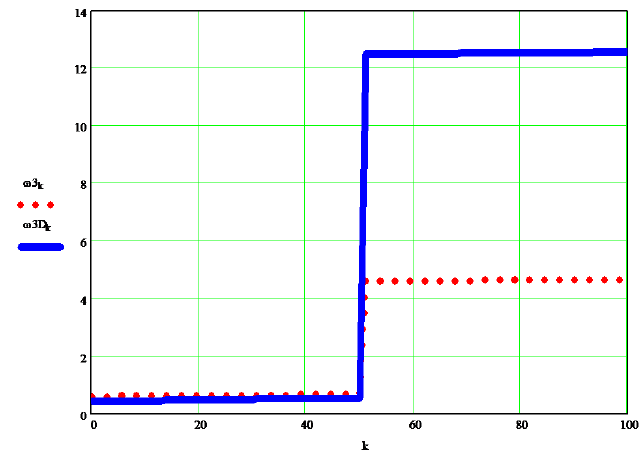
Figure 18. The dynamic angular speed of element 3 of the articulated robot, compared to the input (kinematics) considered speed (to a 6R2T robot).